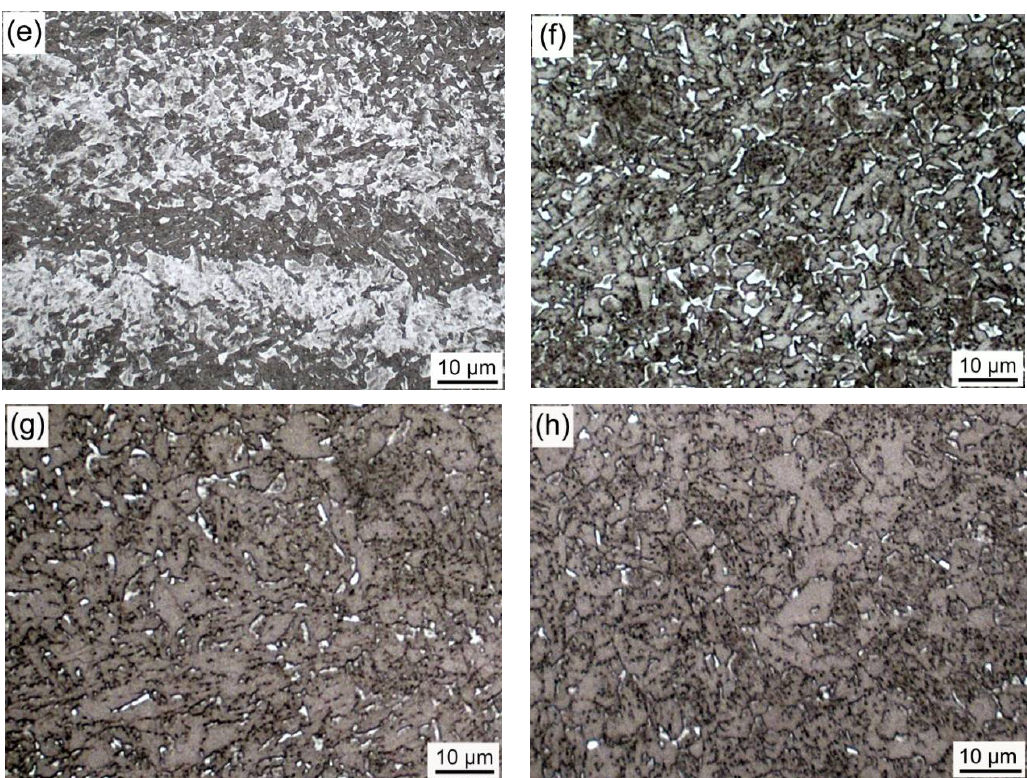
Figure 1. Effect of peak temperature on the microstructures of the IC HAZ: ( a ) 760, ( b ) 765, ( c ) 770, ( d ) 800, ( e ) 830, ( f ) 860, ( g ) 890, and ( h ) 910 °C.